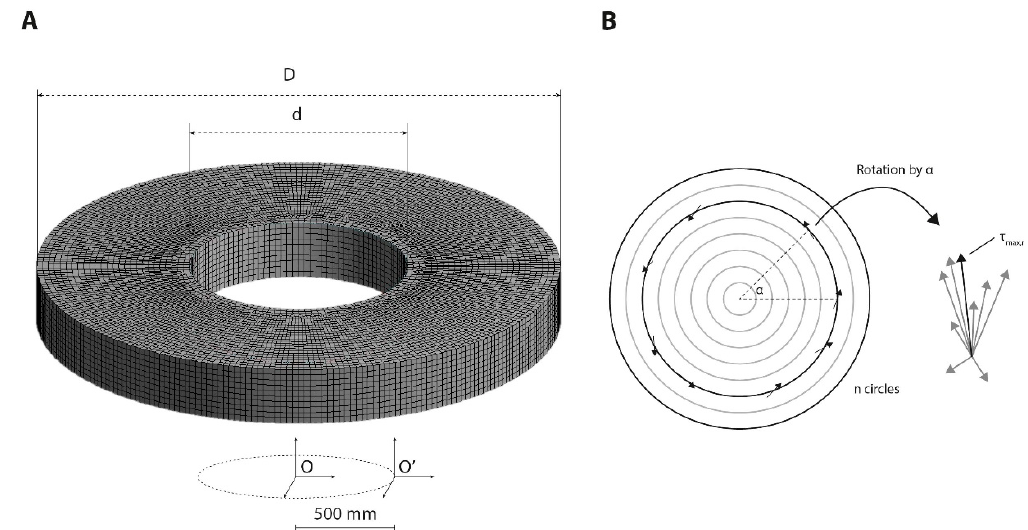
Figure 1. Mesh design and vector analysis. ( A ). Three-dimensional representation of the computational mesh used to model the different geometries, varying the inner (d) and outer (D) diameter. The coordinate system denotes the reference frame of the mesh. ( B ) Schematic representation of the calculation of the low oscillatory shear index (OSI) and τ max . The τ max was extracted from each collection with similar a similar radial position. All vectors are first rotated to α =0 to obtain a time average to calculate the OSI for the variation in shear direction.